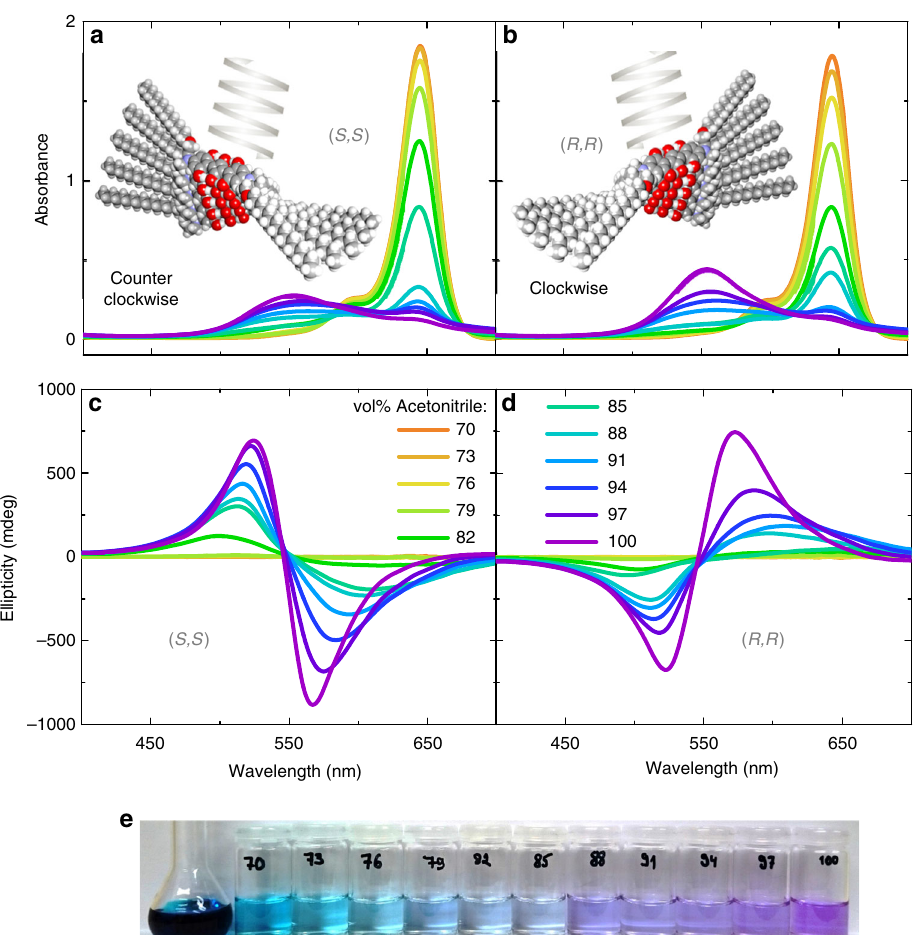
Fig. 1 Early stage aggregation experiments in solution. a , b UV-vis spectra and c , d ellipticity spectra of ( S,S )-ProSQ-C16 and ( R,R )-ProSQ-C16 in mixtures of chloroform and acetonitrile, respectively. The concentration is approximately 5.7 μ M. The volume fraction of acetonitrile is increased as indicated. The insets in a and b illustrate the proposed helical aggregation of the molecules as follows from the line shape of the CD bands. Note that these here are only sketches. In e a photograph of the stock solution and diluted solutions with increasing acetonitrile volume faction from left to right is